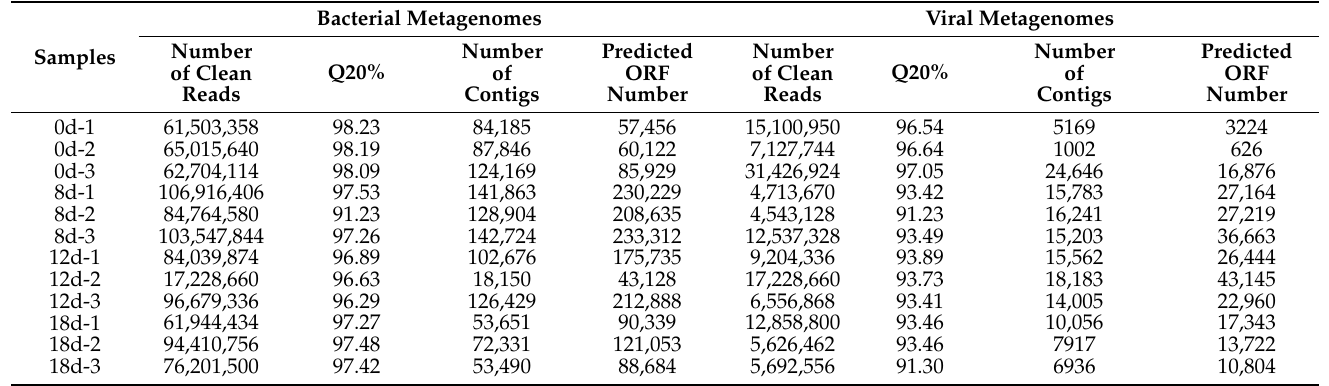
Table 1. Investigation of bacterial and viral metagenomics of vinegar Pei